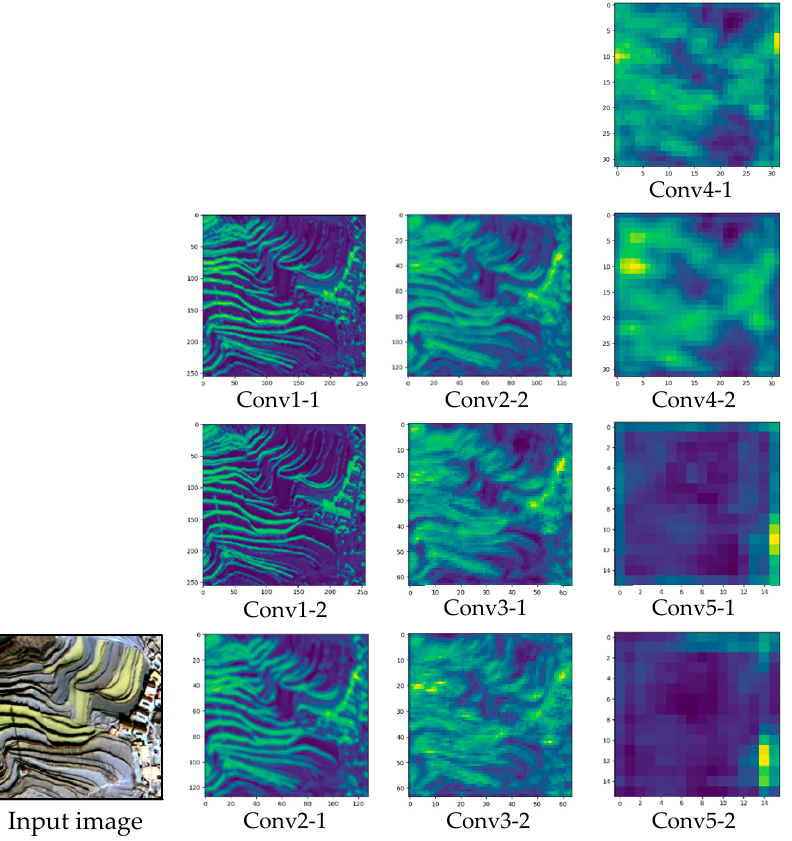
Figure 9. Feature-mapping maps of 10 convolutional layers of the input image. Conv1-1 and Conv1-2 are the feature maps for the two convolutional layers of the first set of convolutional operations, and so on.